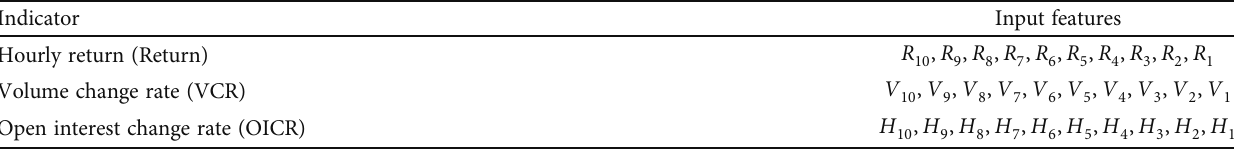
Figure 1: The main structure and working procedures of the proposed method SMOTE-FRS. Table 1: The list of input features for multiclassi fi cation.